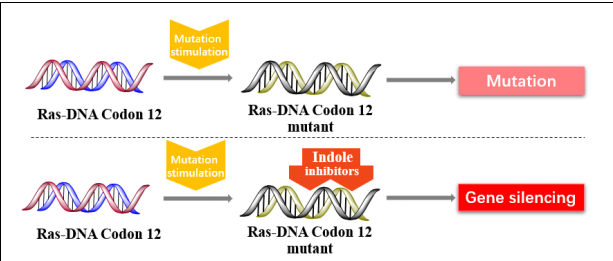
FIGURE 11 | Indole derivatives inhibit the K-RAS codon 12 mutants to silence mutant genes.